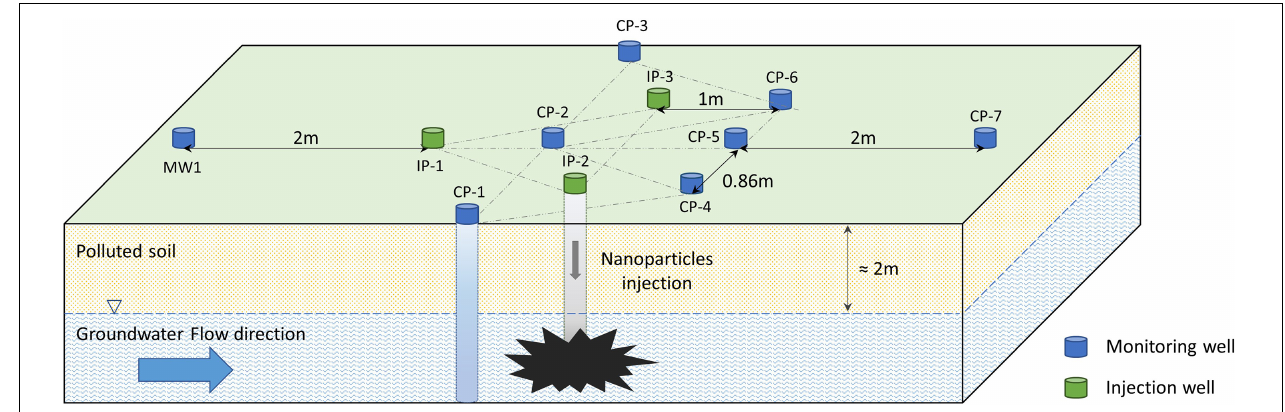
FIGURE 1 | Scheme of the wells excavated in the Nitrastur site for nZVI groundwater treatment. IP, injection wells; CP, monitoring